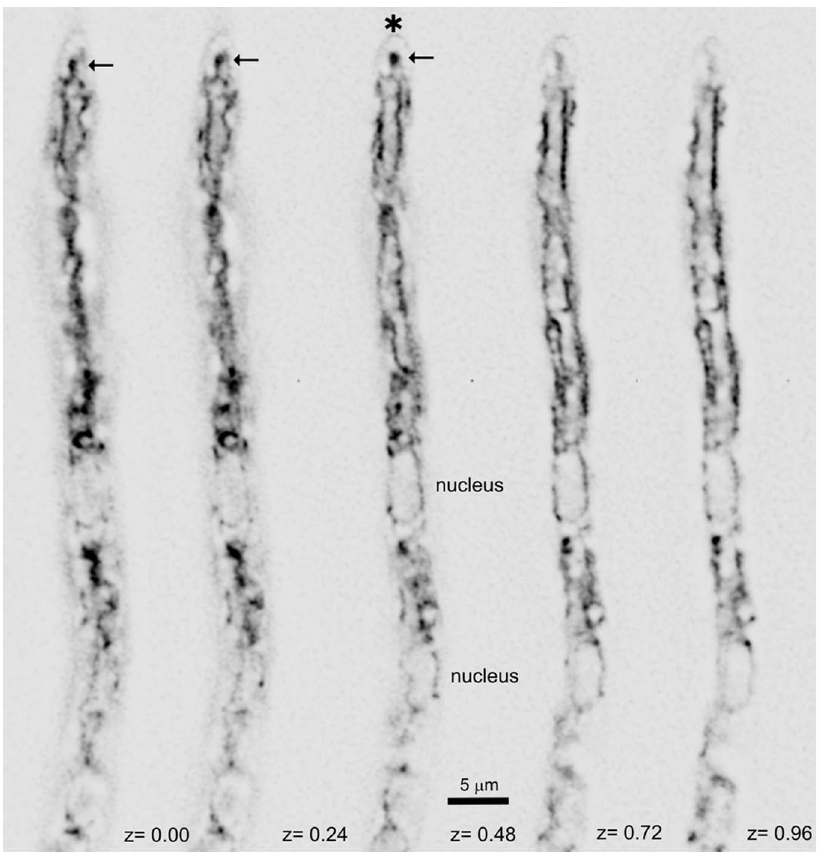
Figure 1. The ER visualized with Sec63-GFP. Different planes (z coordinates indicated in m m) of z-stack of images of a hyphal tip cell. The position of the nucleus is indicated in the middle plane. The asterisk indicates the apical border of the hypha, whereas the arrow indicates the apex- proximal ER protusion.